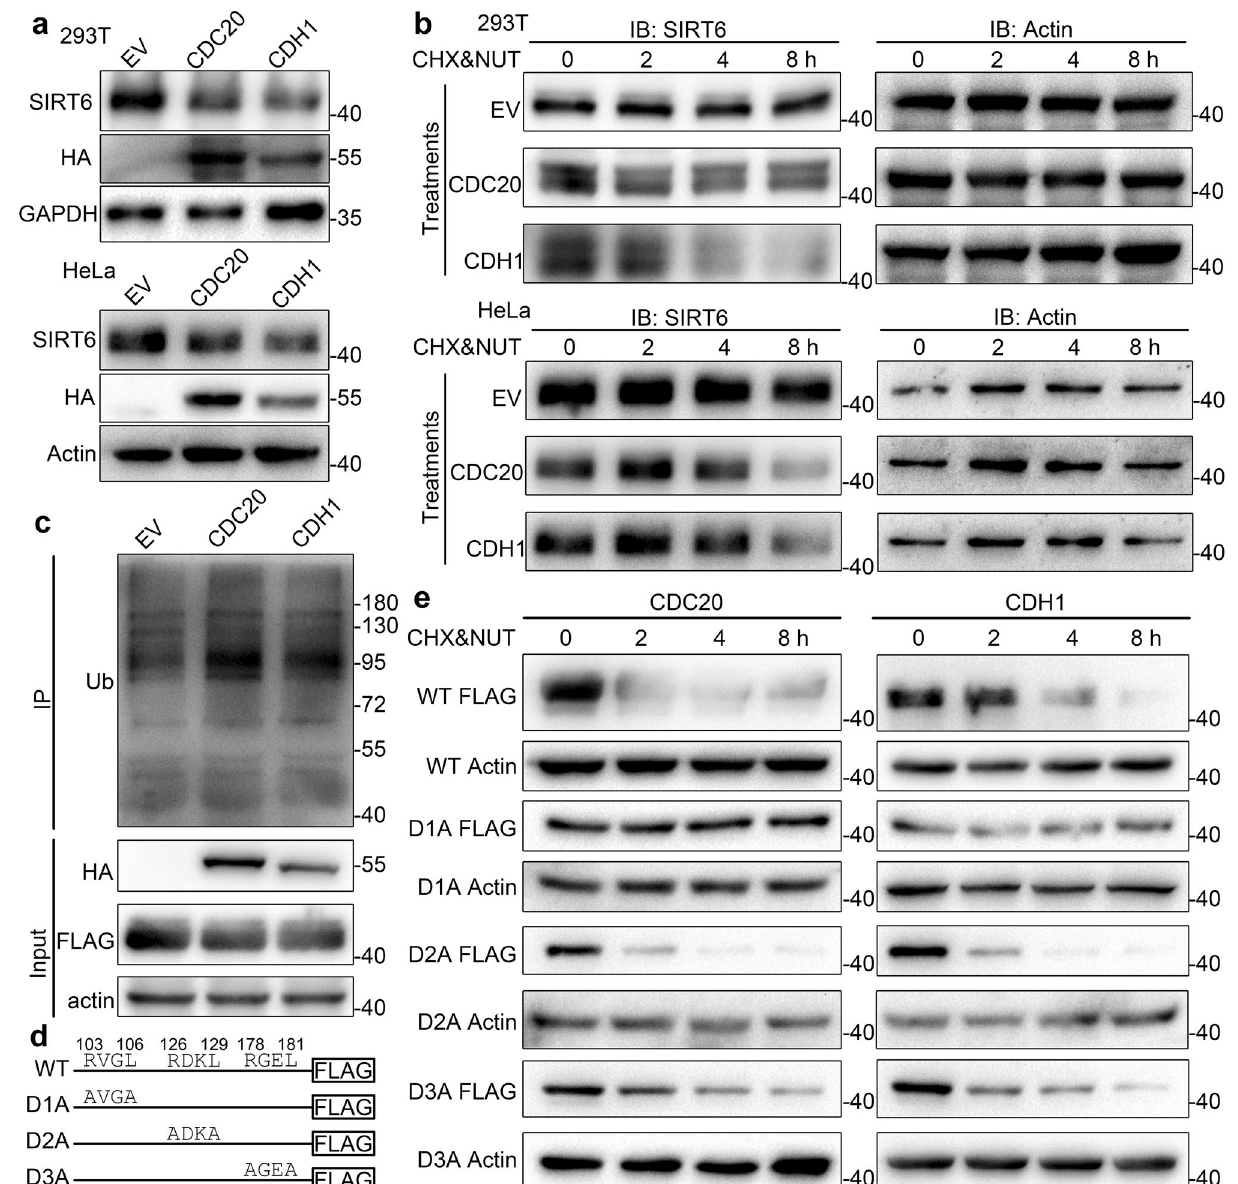
Figure 4. The APC/C leads to SIRT6 degradation through D-box-dependent ubiquitination. ( a ) 293 T and HeLa cells were transfected with empty vehicle and CDC20/CDH1 overexpressing plasmids, respectively. SIRT6 levels were examined by immunoblotting. Actin was used as a loading control. ( b ) 293 T and HeLa cells transiently transfected with empty vehicle (EV) or CDC20/CDH1 overexpressing plasmids were treated with 5 μg/mL cycloheximide (CHX) and 10 μM nutlin-3 (NUT) simultaneously for 0, 2, 4, and 8 h. SIRT6 levels were examined by immunoblotting. Actin was used as a loading control. ( c ) HeLa cells expressing SIRT6-FLAG and myc-Ub were transfected with EV, CDC20-HA, or CDH1-HA overexpressing plasmids, respectively. Cell lysates were subjected to immunoprecipitation with an anti-FLAG antibody and immunoblotted with an anti- ubiquitination antibody. Whole cell lysates were probed with anti-HA and anti-FLAG antibodies. Actin was used as a loading control. This experiment was repeated four times. ( d ) Schematic of wild-type SIRT6 protein showing the positions of the three D-boxes, as well as the D1A (R103A, L106A), D2A (R126A, L129A) and D3A (R178A, L181A) mutants. ( e ) HeLa cells stably expressing FLAG-tagged wild-type or three D-box mutants were transfected with CDC20-HA or CDH1-HA overexpressing plasmids, respectively. Cell were then treated with 5 μg/mL cycloheximide (CHX) and 10 μM nutlin-3 (NUT) simultaneously for 0, 2, 4, and 8 h. Wild-type and mutated SIRT6 protein levels were monitored with anti-FLAG immunoblotting. Actin was used as loading